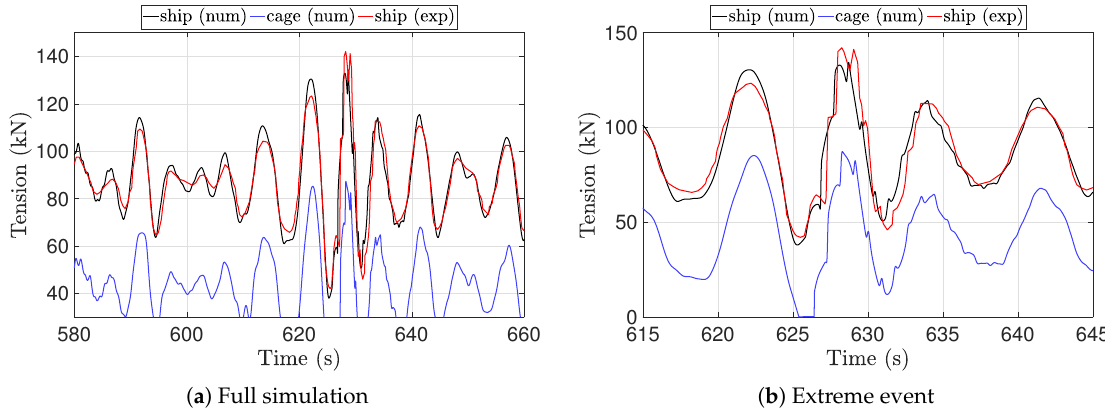
Figure 4. Calibrated results compared with field-test measurements of tether tension at the upper node. ( a ) is the full simulation, and ( b ) shows part of the simulation around the extreme